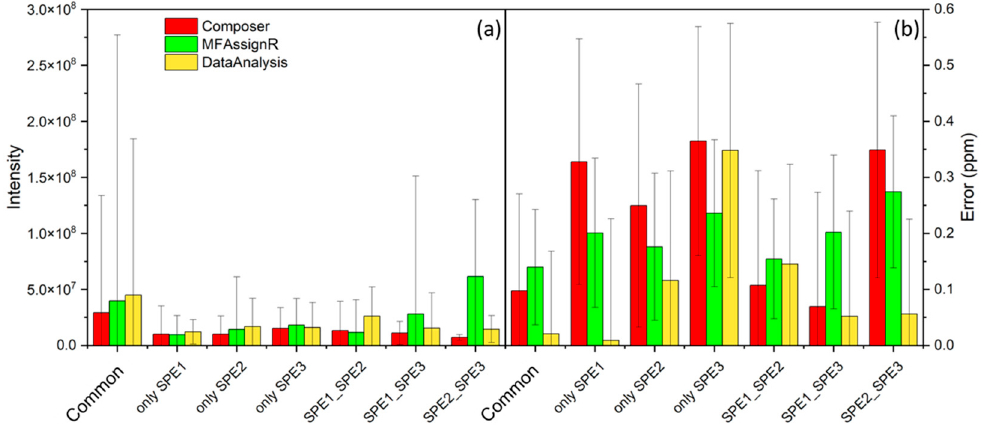
Figure 5. ( a ) Average intensity of the MFs (molecular formulas) common to the three SPE (“Common”); present only in SPE1, SPE2, or SPE3 (“only SPE1”, “only SPE2”, and “only SPE3”, respectively); common to SPE1 and SPE2 (“SPE1_SPE2”); common to SPE1 and SPE3 (“SPE1_SPE3”); and common to SPE2 and SPE3 (“SPE2_SPE3”). The error bars represent the standard deviations of the average intensities. The colors represent the software programs used for the data treatment: red for Composer, green for MFAssignR, and yellow for DataAnalysis. ( b ) Similar to ( a ), average errors (ppm) and standard deviations associated with the attribution of the MFs are given.